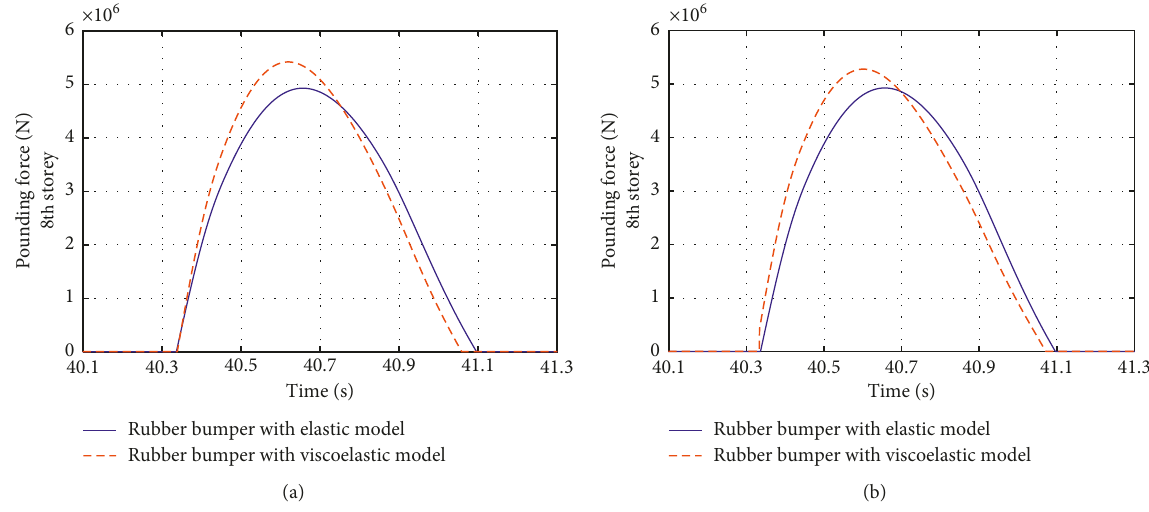
Figure 6: Pounding force time-history with different dash-pot parameters during one pounding process for (a) C C � 4 × 10 4 Pa · 1